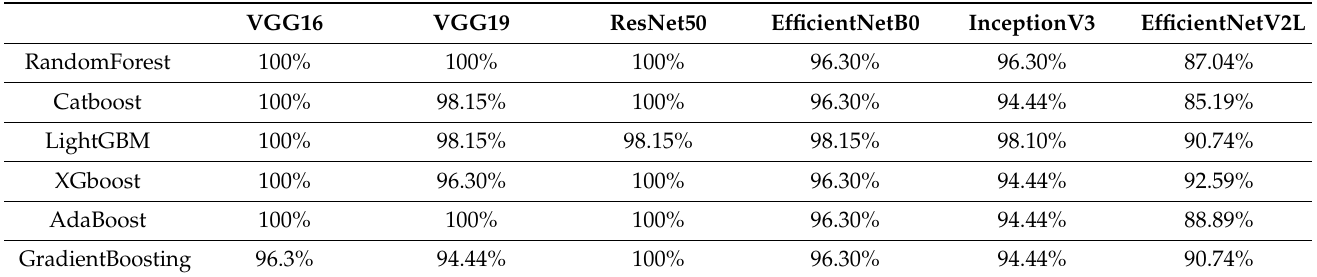
Table A1. Accuracy of each model combination for gray squares.